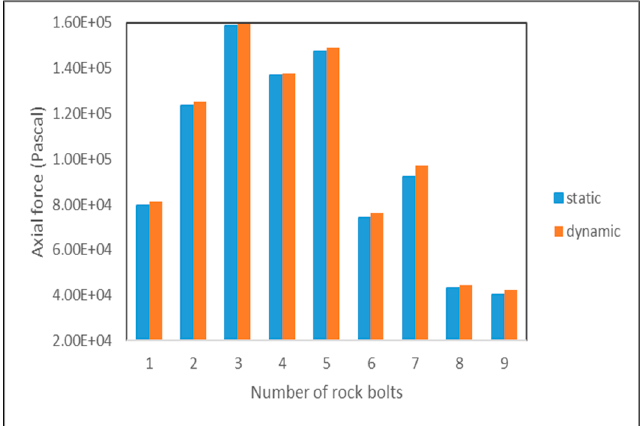
Figure 10. Comparison of axial force of rock bolts under static and dynamic loading in the adjacent tunnel.